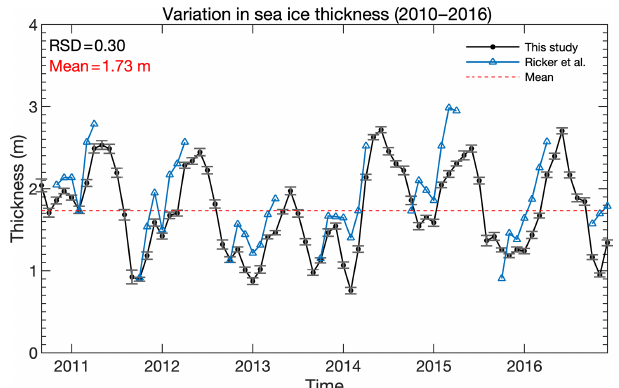
Figure 5. CMST sea ice thickness averaged over the entire Fram Strait gate, from September 2010 to December 2016. The black dot- ted line denotes monthly mean ice thickness based on CMST data with corresponding standard deviations while the blue dotted line represents monthly mean effective sea ice thickness of Ricker at al. (2018).